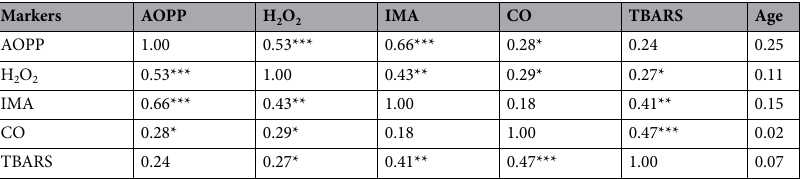
Table 1. Correlation coefficients between approved markers and age. Oxidation parameters: advanced oxidation protein products (AOPP), hydrogen peroxide (H 2 O 2 ), ischemia modified albumin (IMA), carbonyl groups (CO), thiobarbituric acid-reactive substances (TBARS). Correlation coefficients and significance between markers were calculated according to Spearman’s method: *p < 0.05, **p < 0.01, ***p <